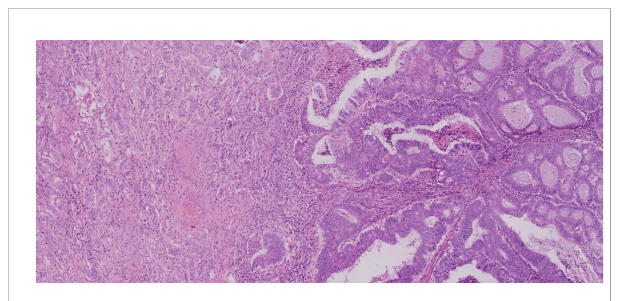
FIGURE 2 Adenocarcinoma and neuroendocrine tumor (NET) were noted in separate areas, but some areas showed